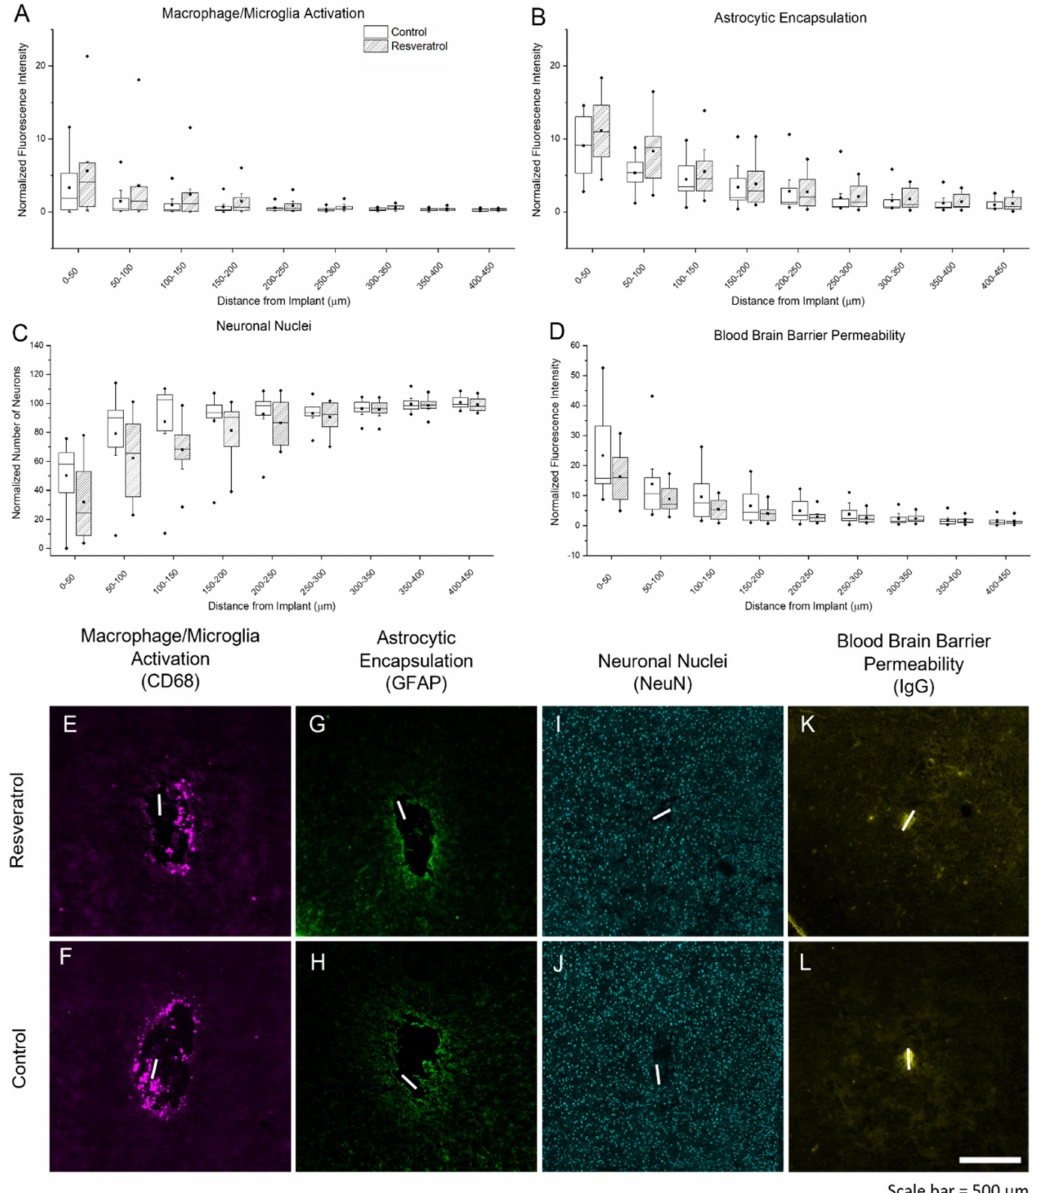
Figure 6. Activation of microglia, macrophage, and astrocytes, neuronal nuclei density, and blood–brain barrier permeability. Fluorescent intensity analysis plots and representative images of activated microglia/macrophage (CD68) ( A , E , F ), astrocytes forming the glial scar (GFAP) ( B , G , H ), and blood–brain barrier permeability (IgG) ( D , K , L ), in bins of 50 µ m width from the electrode implant tract. Neuronal nuclei density (NeuN) ( C , I , J ) was determined by counting neurons in 50 µ m wide bins from the electrode implant tract. The white line depicts the electrode implantation site. The whiskers on the graphs represent the range within 1.5 IQR, the lines inside the boxes represent the median line, the solid squares in the middle represent the mean and the diamonds represent